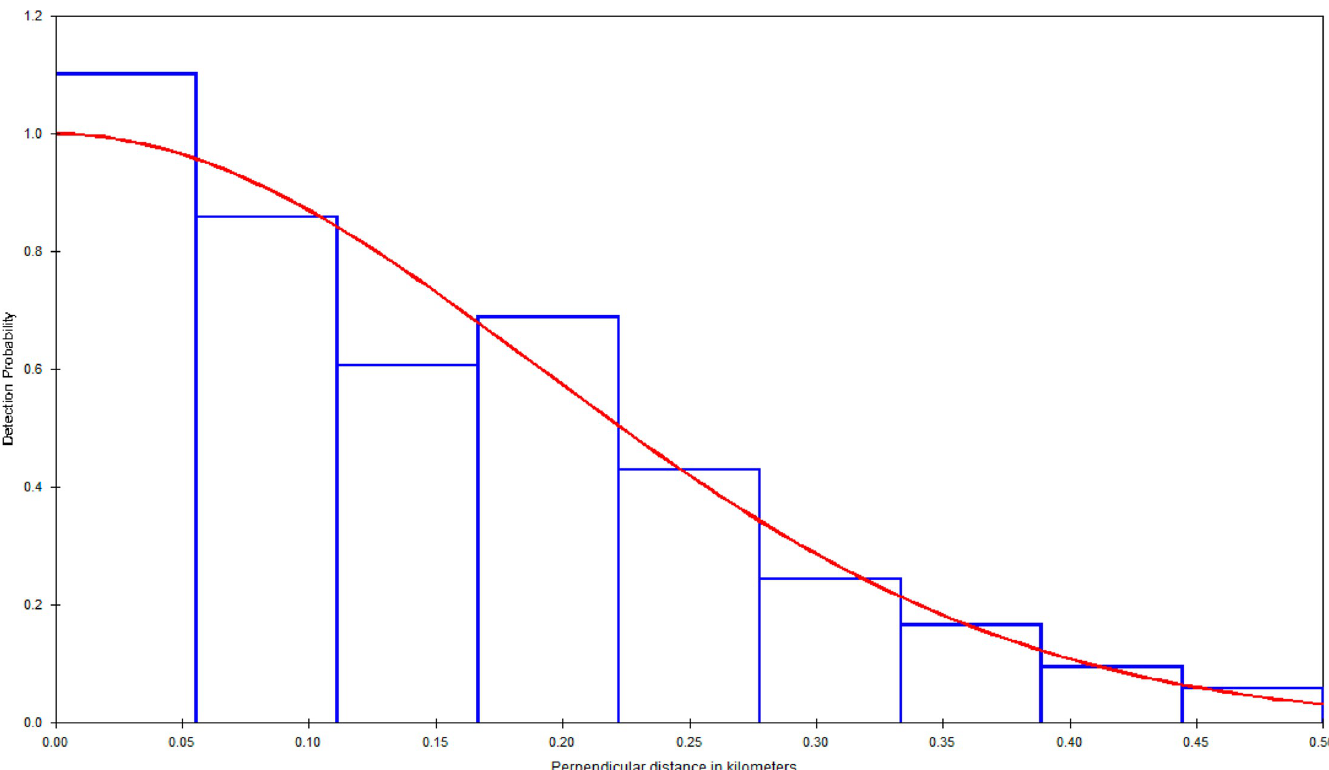
Fig 6. Perpendicular sighting distance histogram and fitted detection function (using a Half-Normal model with cosine adjustment), Northern Inland Waters.